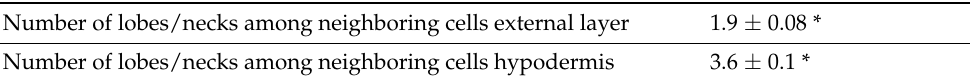
Table 2. Number of lobes/necks among neighboring cells of the external layer and the hypodermis. Data presented are a mean ± standard error of 50 measurements.